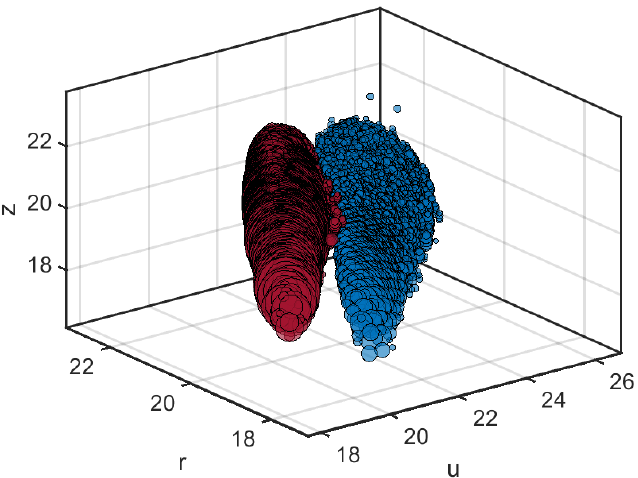
Figure 8. Three-dimensional representations of quasar (red) and non-quasar (blue)